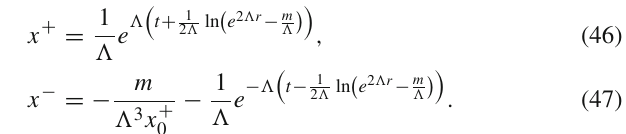
Fig. 2 Penrose diagram for RST spacetime where a black hole is cre-